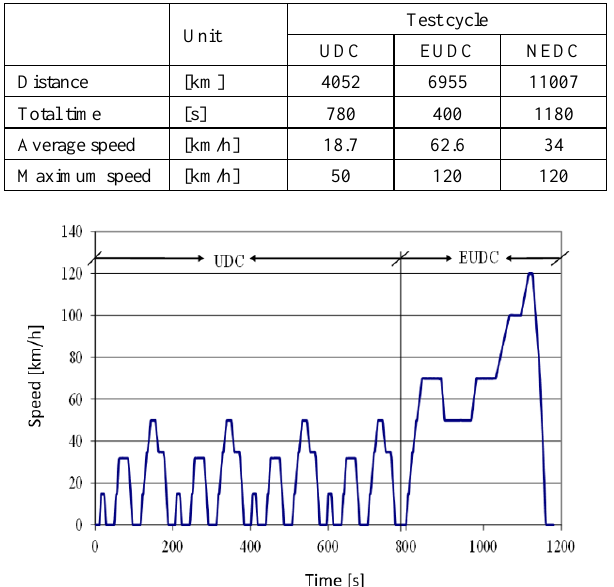
Table 1. Basic parameters of the NEDC test cycle and its parts UDC and EUDC test cycles [1]